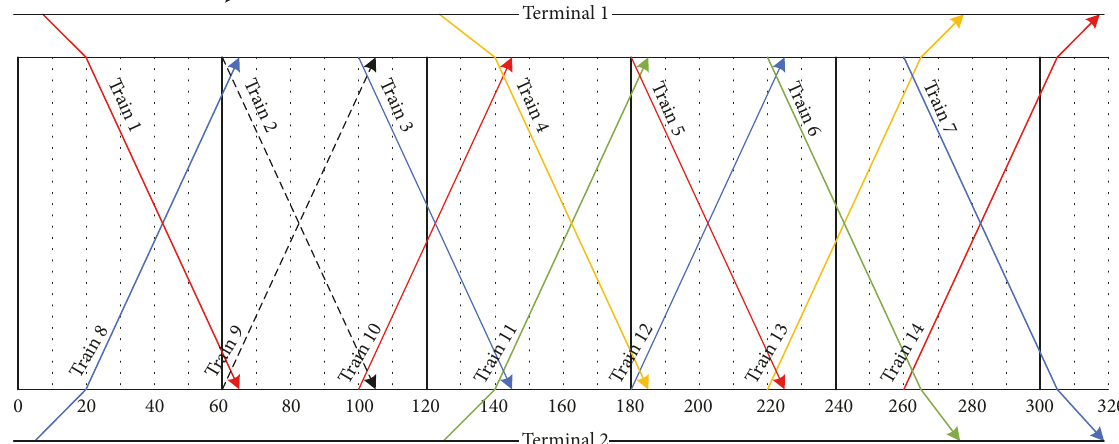
Figure 1: The initial timetable and the corresponding vehicle schedule solution.